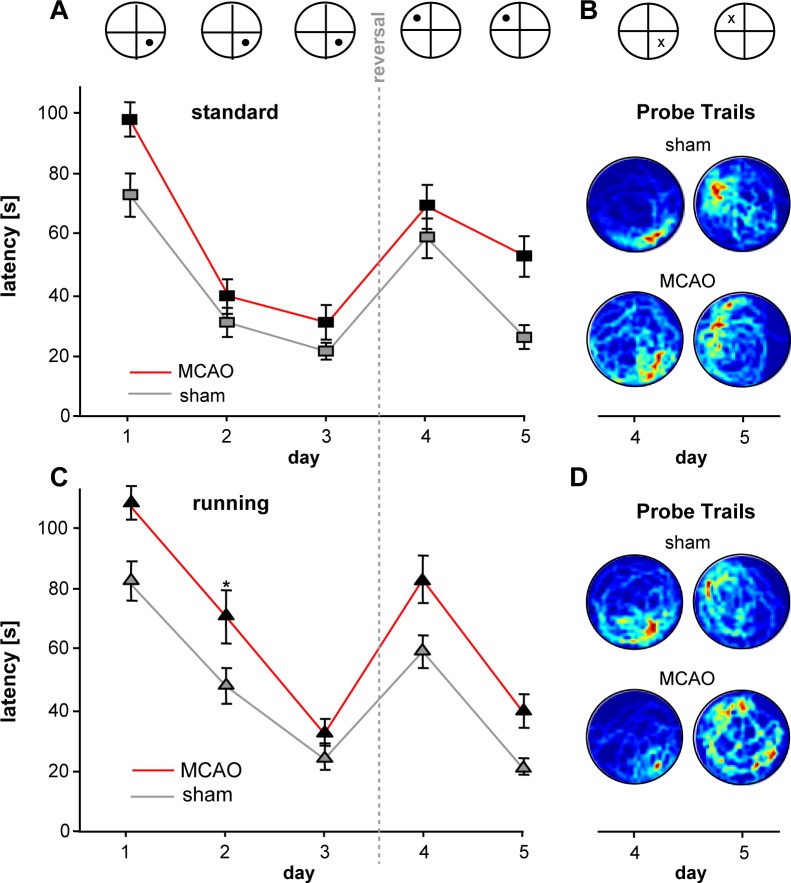
Spatial learning is impaired following stroke.A/C, Graphs reveal time (latencies) to navigate to the platform in MWM either following standard housing (A) or free access to running wheels (C), red = MCAO, grey = sham. B/D Heat maps of probe trails at days 4 and 5. Dark-red zones indicate a high presence probability. In the upper panel of A-B, the platform position is schematically illustrated. During the probe trails, the platform is removed and the putative position is marked with x.